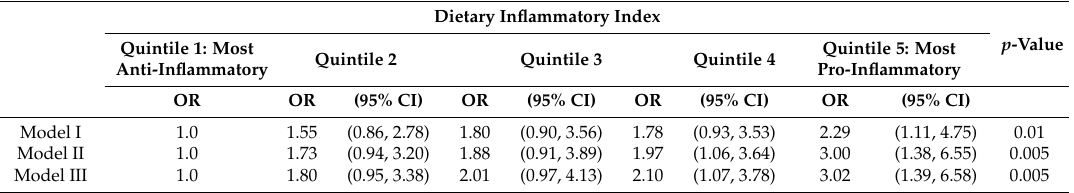
Model I: Adjusted by age and sex. Model II: Model I plus physical activity (inactive vs. active/highly active); hours of television watching; tobacco use (current, past, and never); socioeconomic status (low, medium, and high); education